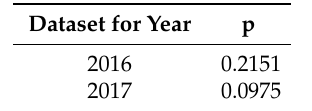
Table 3. The result of the p -value Shapiro-Wilk Normality